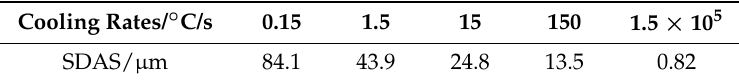
Table 3. SDAS of the alloy ingot at different cooling rates.